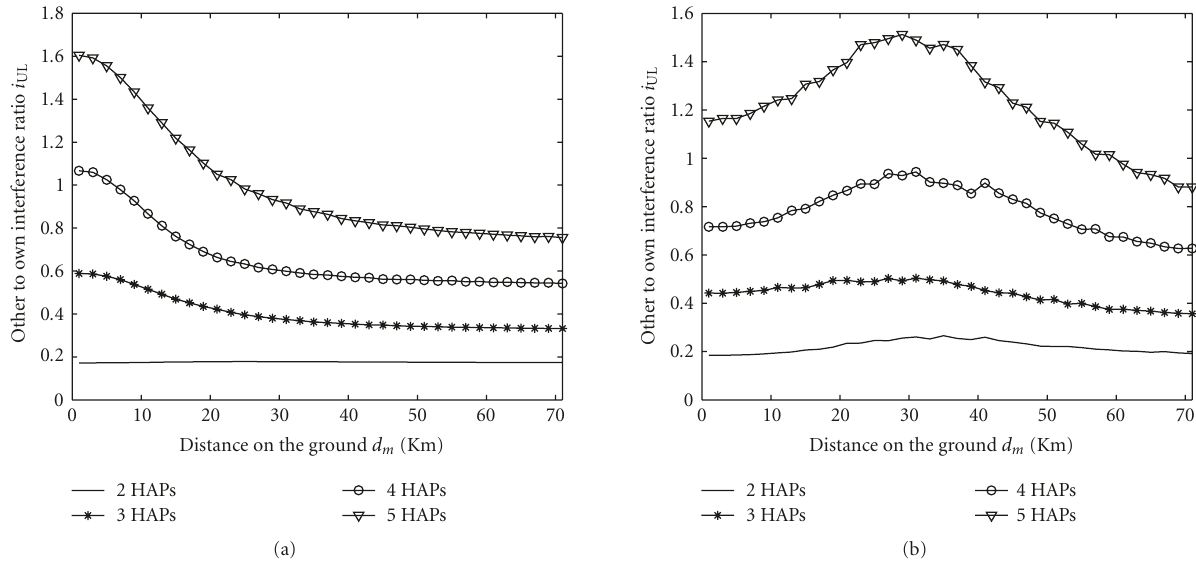
Figure 5: The performance of the voice service (12kbps) from one HAP in combination with the data service (384 kbps) on the remaining HAPs for cell radius of 10 km (a) and 30 km (b). The distance on the ground d m is varied from 0 to